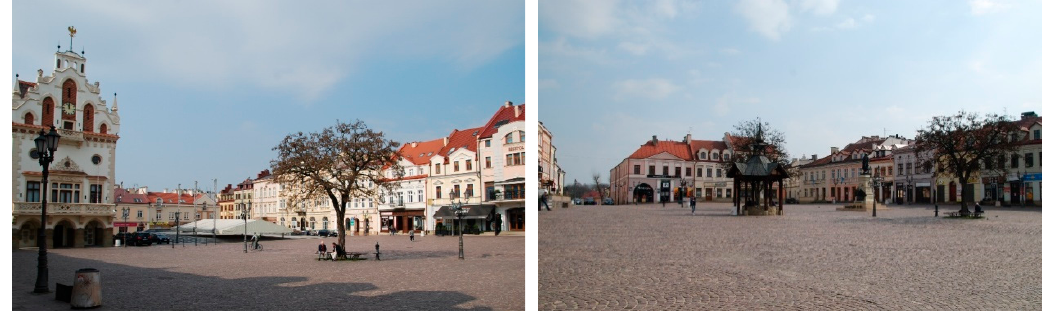
Figure 3. Main Market Square in Rzesz ó w. Source: own